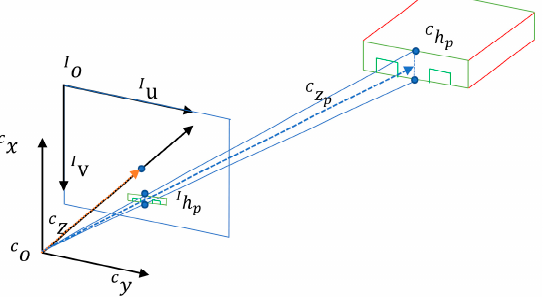
Figure 5. Labeled template example. Element labels are represented with different colors. Green represents goods. Red represents pallets. Blue represents ground. Light blue represents pallet holes. The grids are compression units of label templet. 𝑠 (cid:3048) and 𝑇 (cid:3036)(cid:3037) represent the grid compressing unit size and the grid unit vector of Labeled templet, respectively (explained in Section 2.5 below). The pallet foot detection grids are explained in Section 2.7 below.